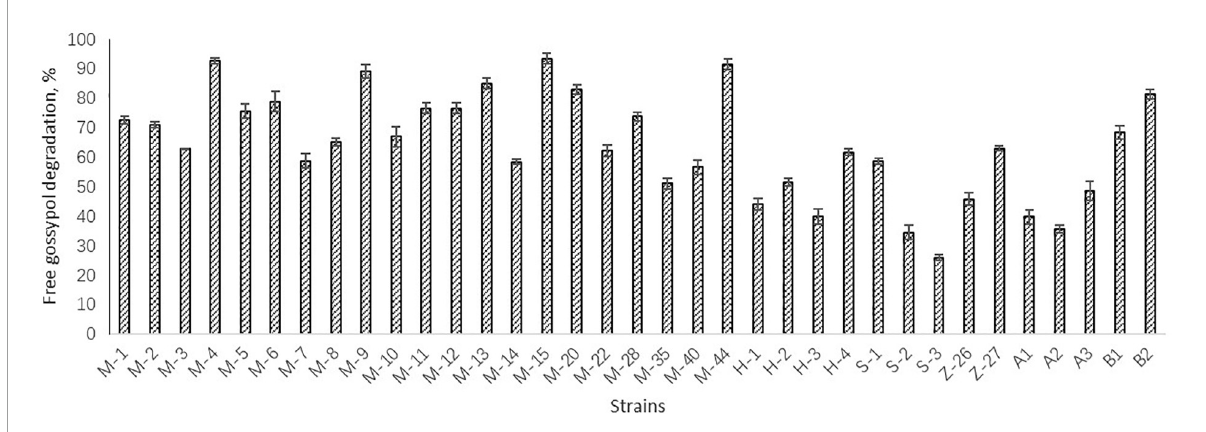
FIGURE1 Degradation activity of free gossypol of strains. Values are expressed as averages ± standard deviation